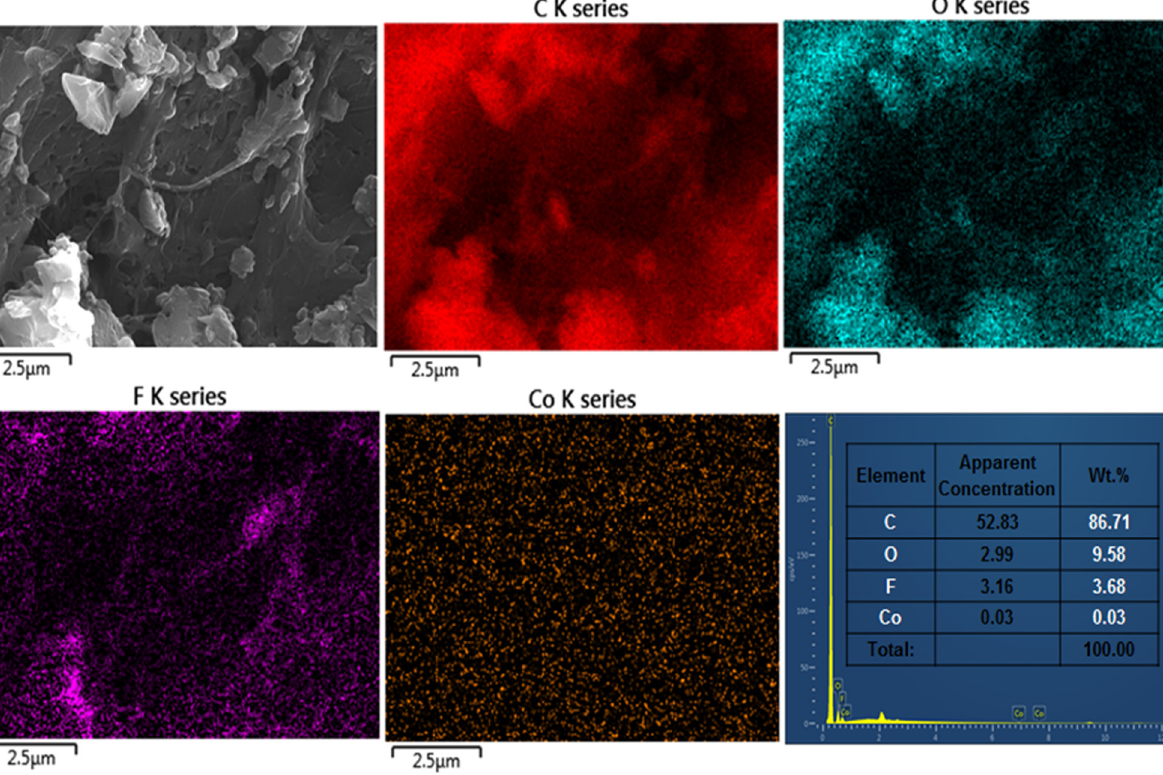
Figure 7: EDX mapping for the fracture surface of CNCPC